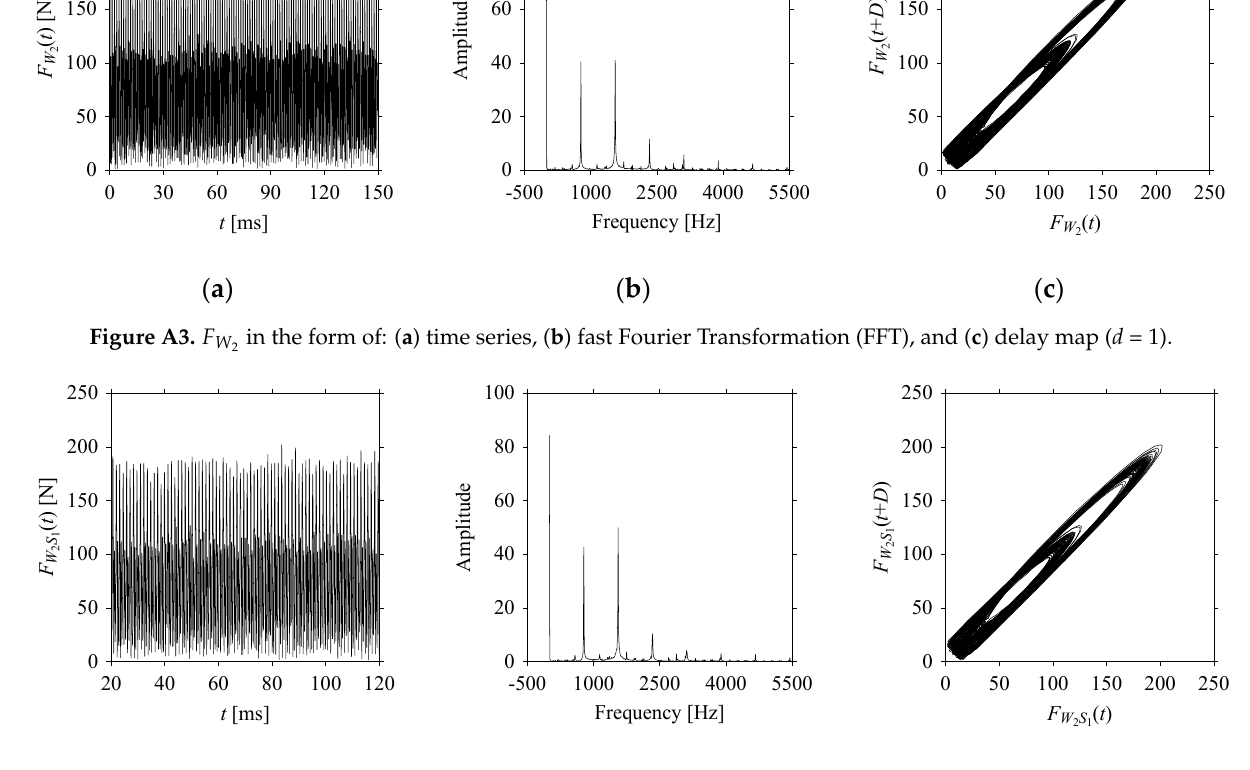
Figure A4. F W in the form of: ( a ) time series, ( b ) fast Fourier Transformation (FFT), and ( c ) delay map ( d = 1). 2 S 1